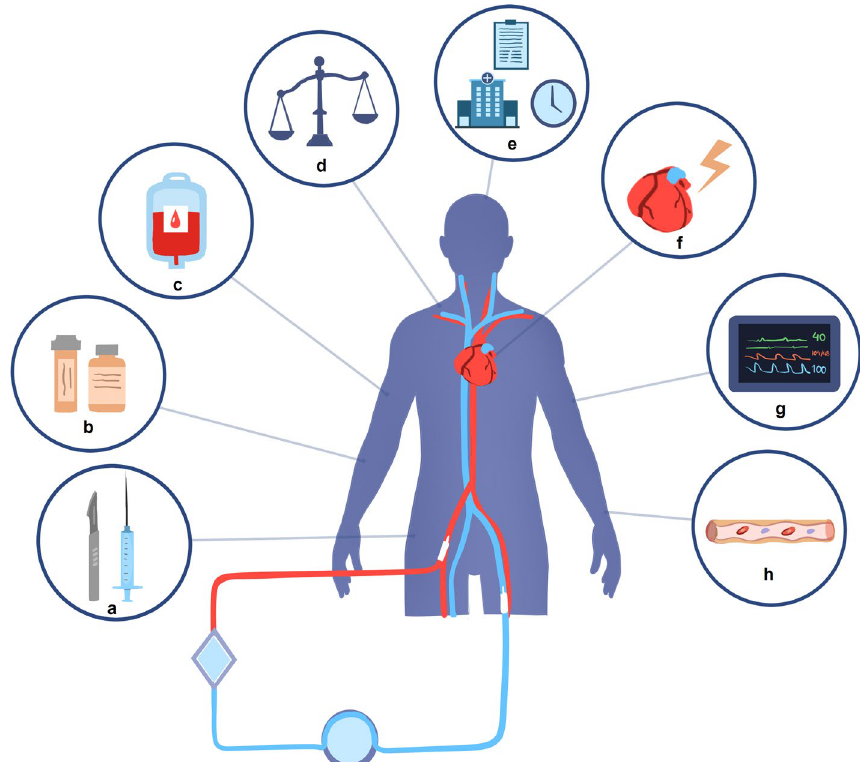
Fig. 1 Priority topics further elaborated in this review. From left to right: a percutaneous versus surgical methods of cannulation, b anticoagulant therapies, c blood transfusion regimen, d daily therapy goals, e ECPR selection criteria, f cardiogenic shock, g optimal balance of blood pressure and vasoactive medication, h endothelial activation and damage. © Myrthe